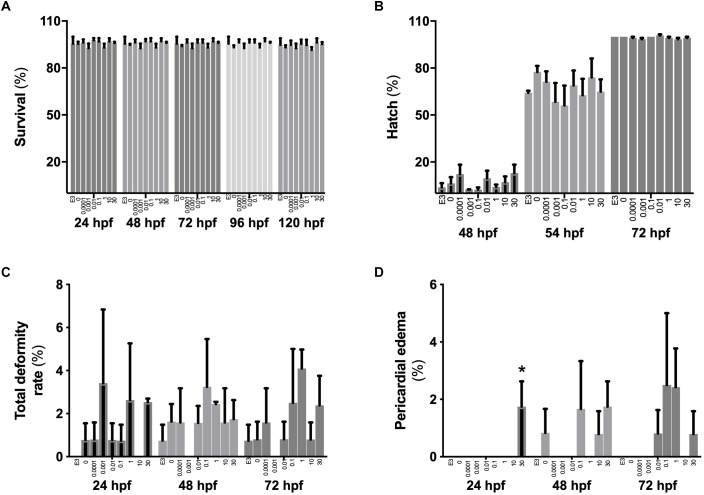
The effects of BPA on zebrafish embryo survival, hatch and rates of deformities. Survival (A), hatch rates (B) and rates of total deformities (C) or pericardial edema (D) in zebrafish embryos when exposed from 2 to 26 hpf to increasing concentrations of BPA. Bars within each time period group represent mean ± SEM, n = 3 of E3 controls, DMSO controls, 0.0001, 0.001, 0.01, 0.1, 1, 10, and 30 μM BPA (left to right). Asterisk indicates statistical differences in mean values between treatments (one-way ANOVA, Tukey post hoc test, p < 0.05).